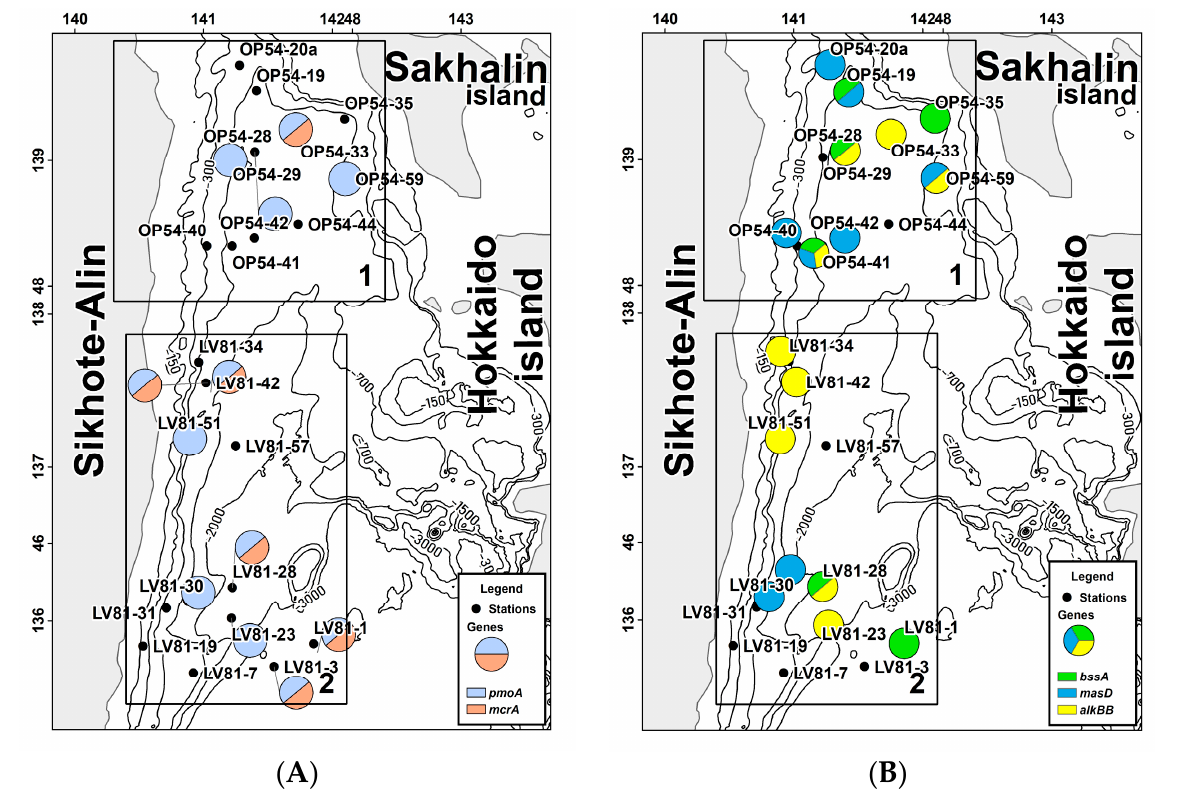
Figure 2. Distribution of functional bioindicator genes in bottom sediments of the northern part of the Sea of Japan. The stations are divided into (1) the gas-hydrate area and (2) the non-gas-hydrate area. ( A ) Methane cycle; ( B ) Biodegradation of hydrocarbons.